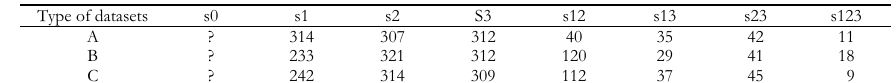
Capture profiles of the simulated datasets